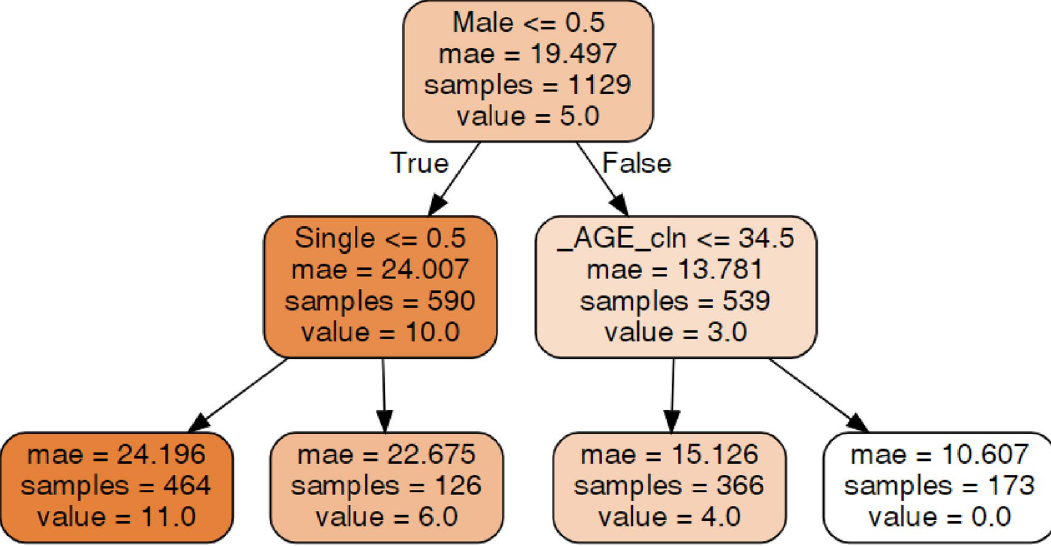
Figure 5. Example of a decision tree with the Migraine Disability Assessment (MIDAS) target variable. Source: author-generated tree using the sklearn and graphviz